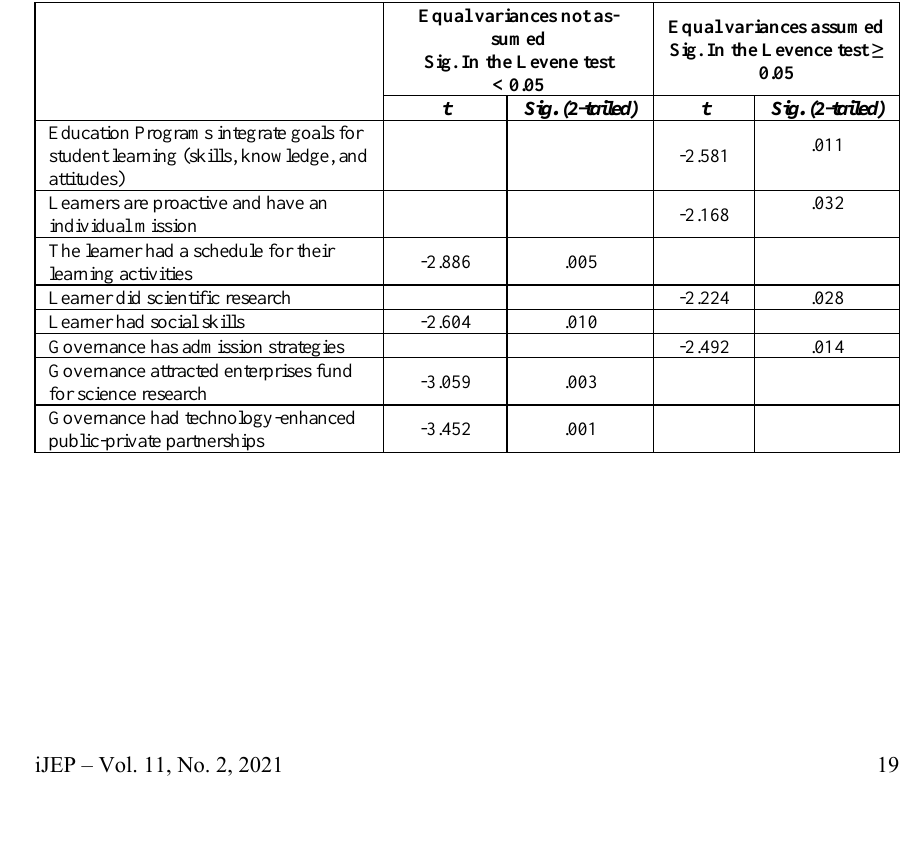
Levene's Test for Equali- ty of Variances